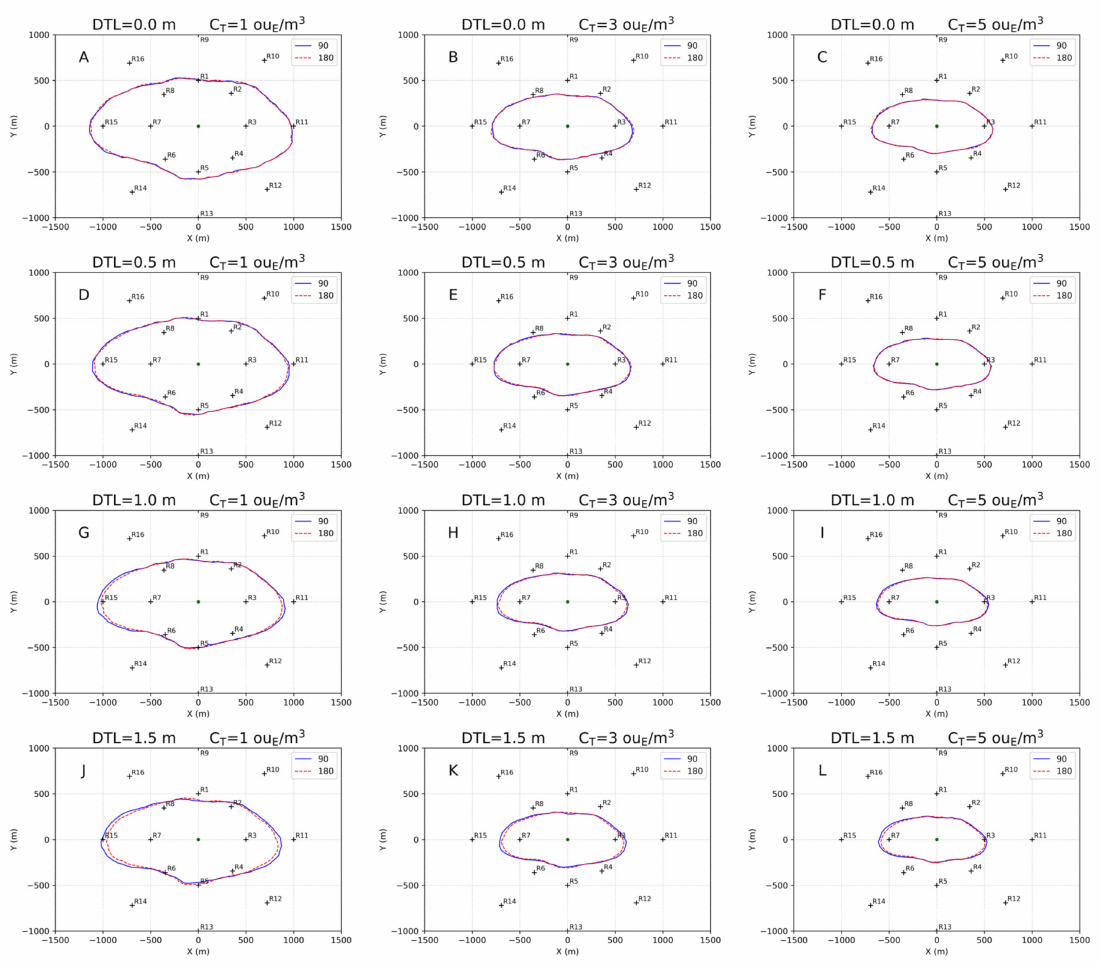
Figure 11. Tank L12_W7.5. Separation distances calculated for the base case (top row) and as a function of the tank orientation and DTL of 0.5 m (second row), 1.0 m (third row) and 1.5 m (bottom row). Concentration thresholds are 1 ouE/m 3 (left column), 3 ouE/m 3 (central column) and 5 ouE/m 3 (right column). The dark green circle represents the centroid of the sources, while the black crosses represent the discrete receptors. ( A ): DTL = 0.0 m, C T = 1 ouE/m 3 . ( B ): DTL = 0.0 m, C T = 3 ouE/m 3 . ( C ): DTL = 0.0 m, C T = 5 ouE/m 3 . ( D ): DTL = 0.5 m, C T = 1 ouE/m 3 . ( E ): DTL = 0.5 m, C T = 3 ouE/m 3 . ( F ): DTL = 0.5 m, C T = 5 ouE/m 3 . ( G ): DTL = 1.0 m, C T = 1 ouE/m 3 . ( H ): DTL = 1.0 m, C T = 3 ouE/m 3